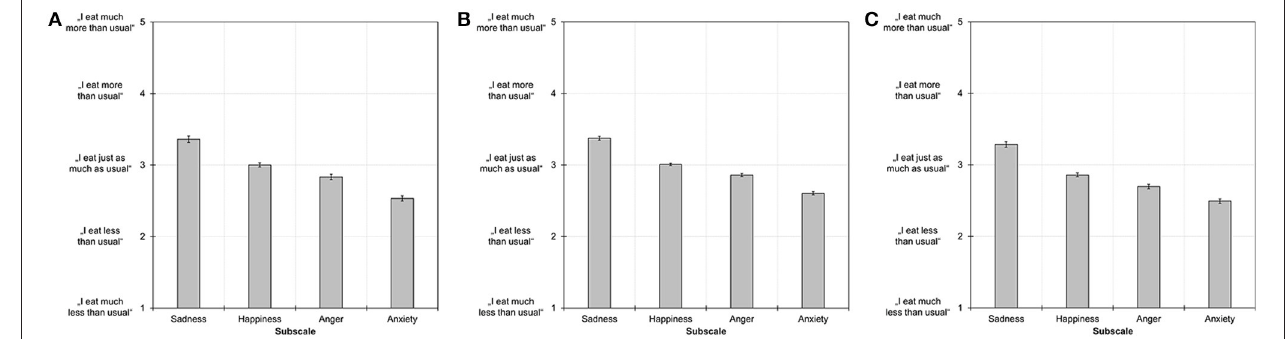
TABLE 3 | Descriptive statistics and internal consistency of and correlations between the four subscales of the Salzburg Emotional Eating Scale in study 2. n = 790 M SD Range